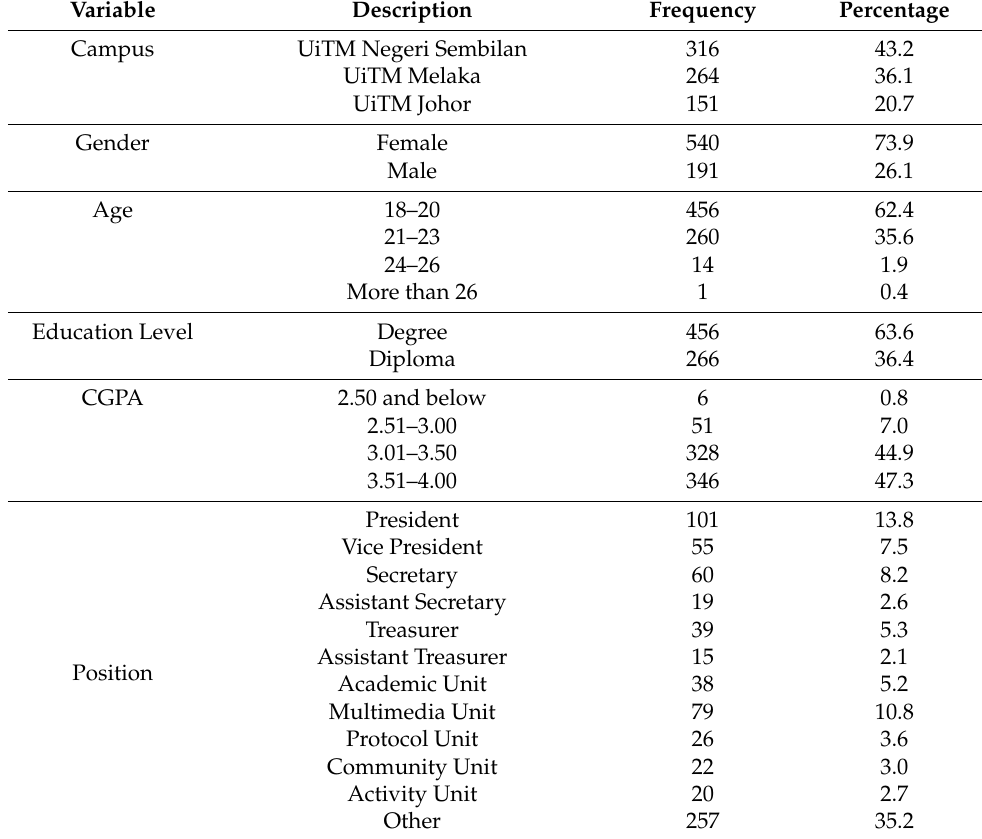
Table 1. Descriptive statistics of respondents’ demographic background.